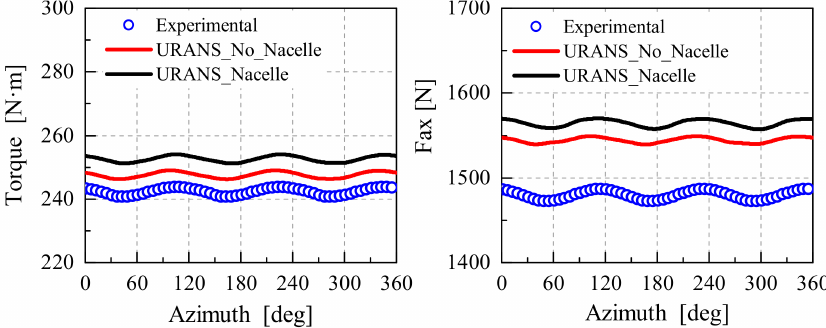
Figure 7. Comparisons of the rotor torque and thrust regarding the nacelle effect.